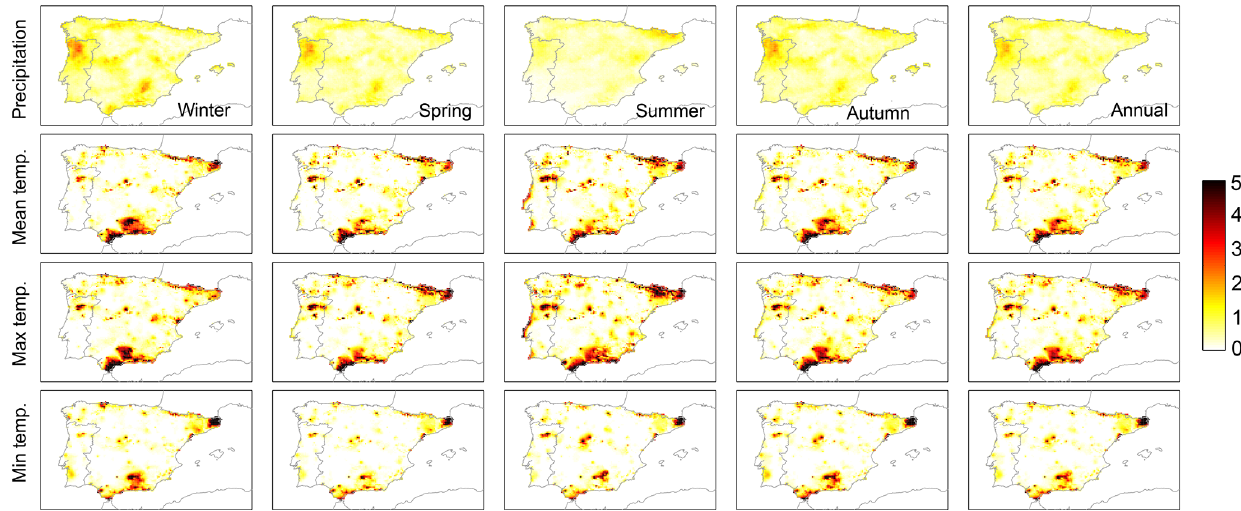
Figure 3. Percentage of significantly different days between Iberia01 and E-OBS v17e for each grid box, variable, and season, defined as the Iberia01 daily values outside the P5–P95 percentile interval of the normal distribution given by the E-OBS ensemble, in the period 1970–2015 for wet days (first row), and mean (second row), maximum (third row), and (fourth row) minimum temperatures.